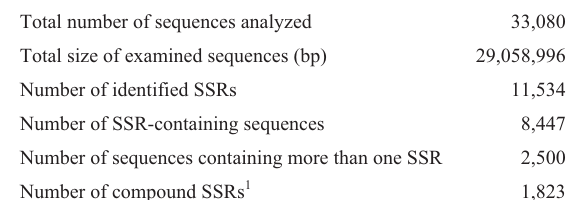
Figure 2 - Distribution of SSRs into classes in Eucalyptus spp. from the FORESTs database (11,534